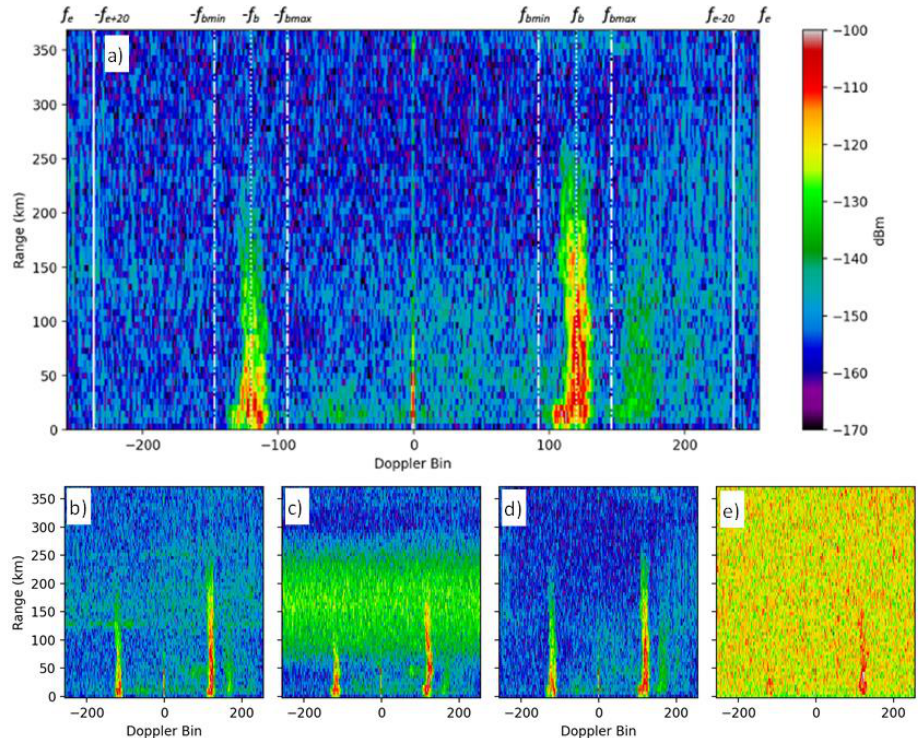
Figure 2. ( a ) Example HFR backscatter doppler spectrum. Bragg regions are centered on f b and limited by f bmin and f bmax on the positive and negative sides of the spectrum. Maximum signal, S max , is defined as the maximum signal of the Bragg regions on both sides. Clutter + noise floor, C+NF, is defined as the average of the edge region on each side of the spectrum defined by the doppler frequency at 20 doppler bins from the extremity (f e+20 ) and doppler frequency at the extremity (f e ). Figure 2b–e show a series of HFR backscatter spectra from selected times within one day on ( b ) 2 April 2017 07:45 LT, ( c ) 11:16 LT, ( d ) 17:06 LT, ( e ) 23:22 LT showing a progression of increased clutter during the daytime and high noise at nighttime.